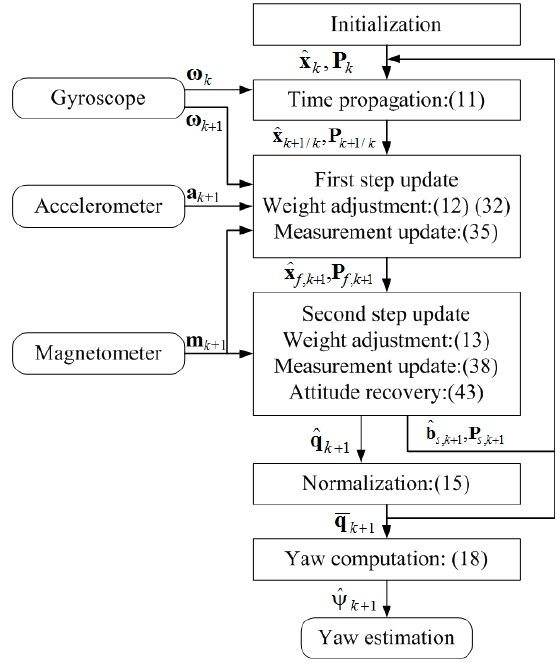
Figure 2. Improved yaw estimation algorithm.